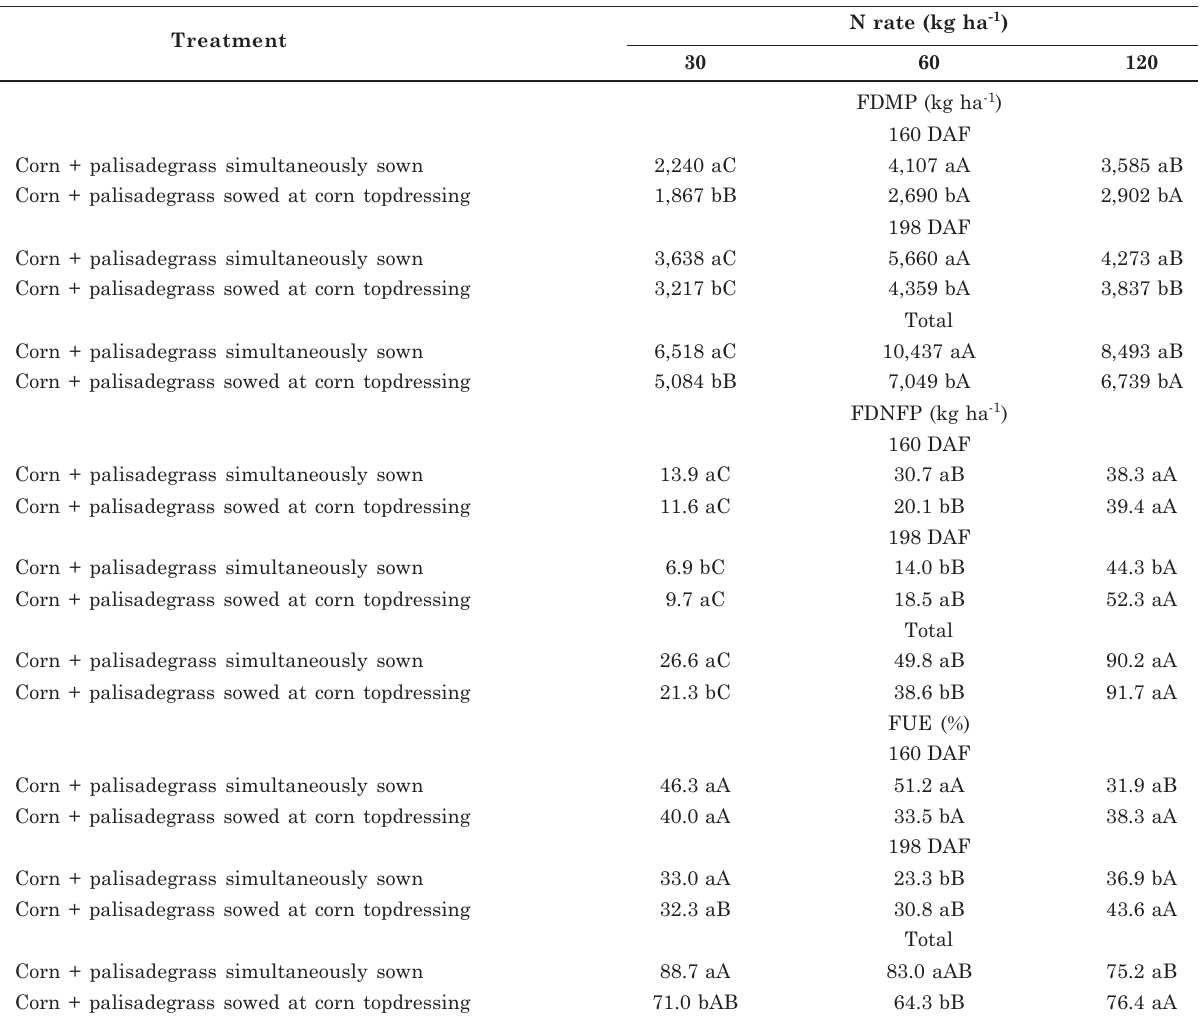
Table 2. Interaction split between intercrop sowing times × N rates ( 15 NH 4 NO 3 source) applied after corn harvest for forage dry matter production (FDMP), amount of fertilizer-derived nitrogen in the plant (FDNFP) and fertilizer use efficiency (FUE) of palisadegrass, in two evaluation periods (160 and 198 days after fertilization - DAF) and